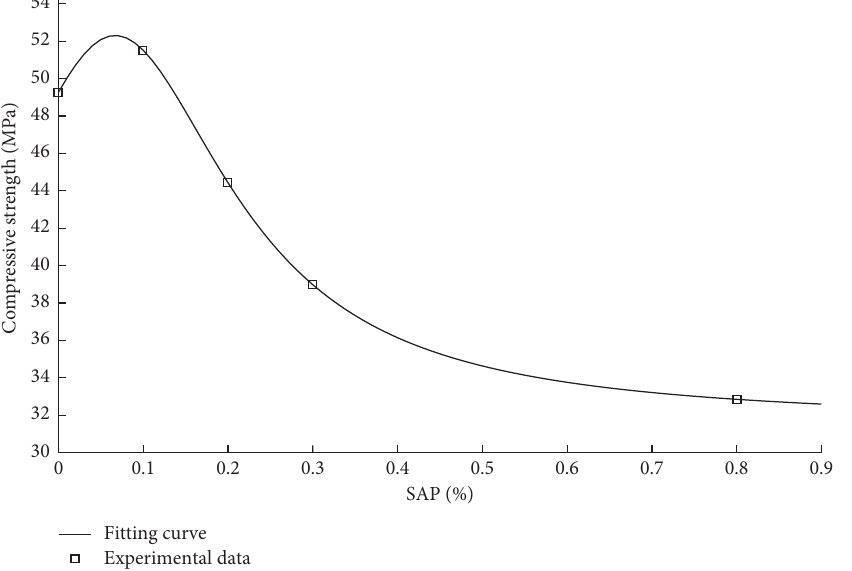
Figure 5: Relationship between SAP content and compressive strength. Table 3: Theoretical and experimental results of compressive strength of SAP concrete.